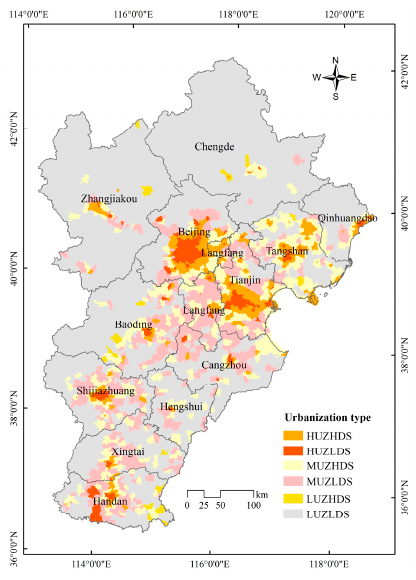
Figure 4. Spatial pattern of urbanization types in Beijing-Tianjin-Hebei urban agglomeration during 2000–2012. Table 1. Area ratio of different cities for each urbanization type in Beijing-Tianjin-Hebei urban agglomeration (unit: %).